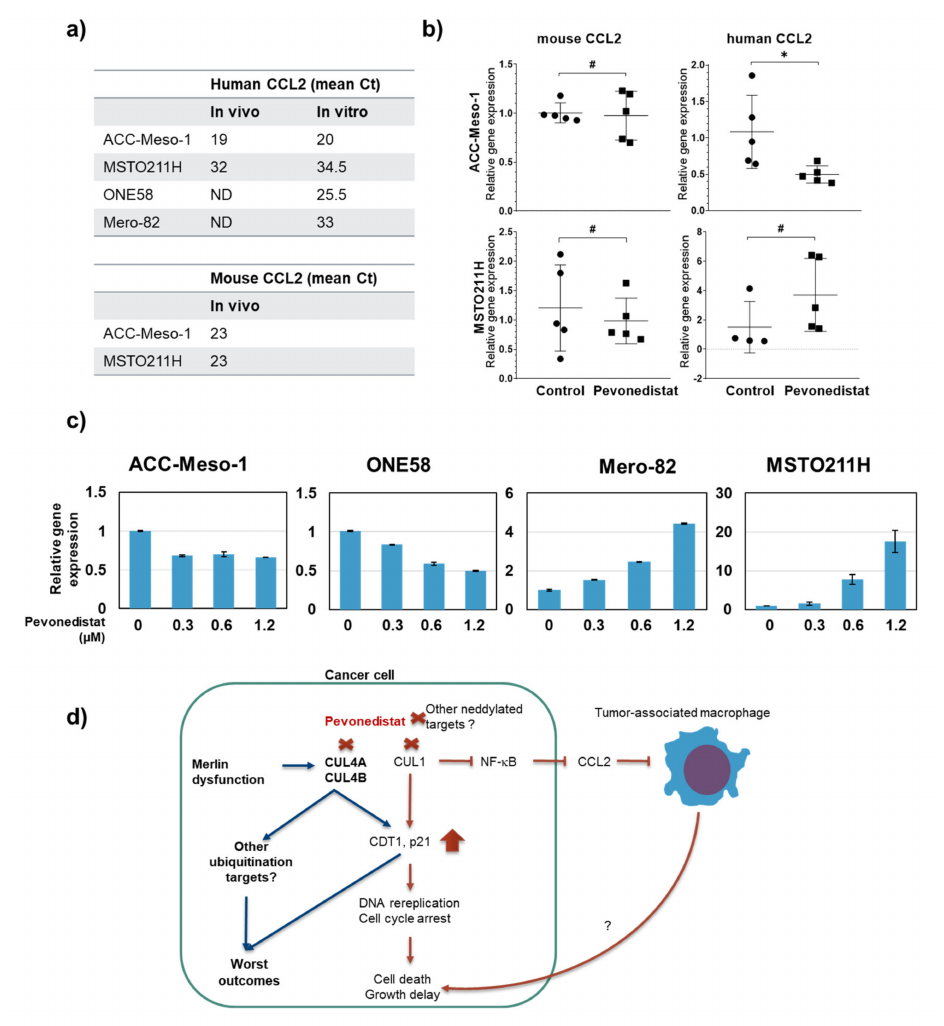
Figure 6. E ff ect of pevonedistat treatment on the expression of CCL2. ( a ) Comparison of the baseline expression levels of CCL2 in four di ff erent MPM cell lines in vitro. Lower Ct is equivalent to a higher expression. ( b ) qPCR analysis using mouse and human-specific CCL2 primers (using